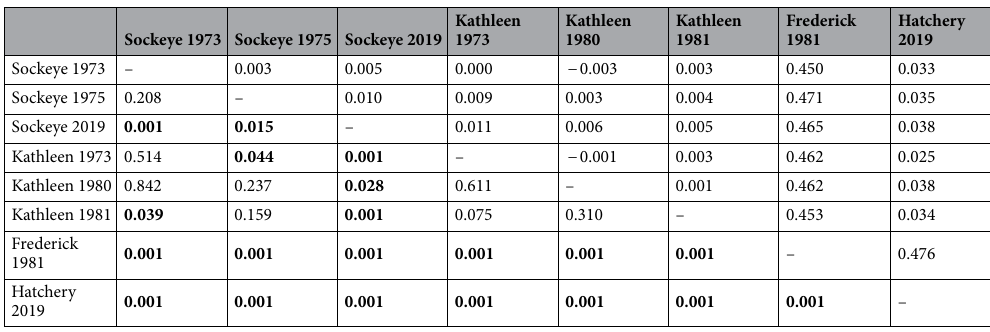
Table 2. Differentiation (Weir and Cockerham’s θ ) 48 (above the diagonal) and p -values (below the diagonal, bolded values ≤ 0.05) for individuals in Sockeye Lake, Kathleen Lake, Frederick Lake, and the Whitehorse Rapids Fish Hatchery (neutral, 271